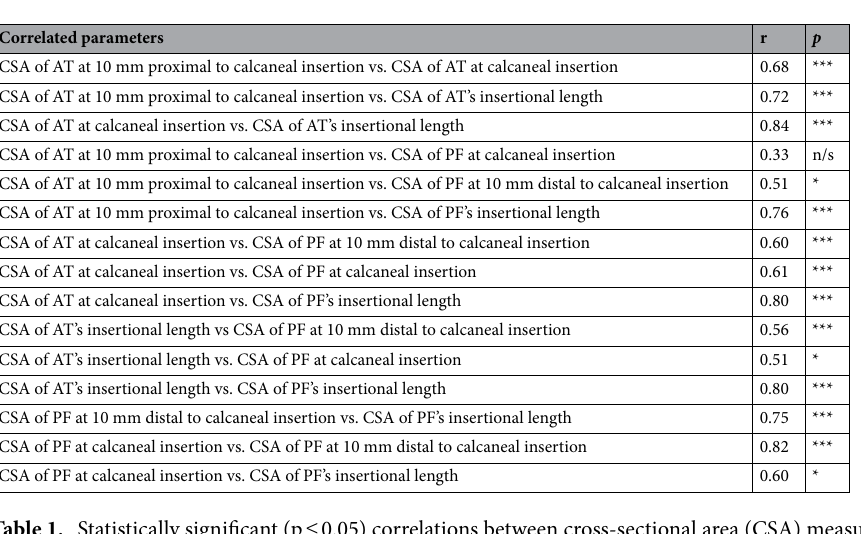
Table 1. Statistically significant (p ≤ 0.05) correlations between cross-sectional area (CSA) measurements of Achilles tendon (AT) and plantar fascia (PF); Fig. 2 provides a graphical depiction of the measurement sites. P p-value; r correlation coefficient; n/s not significant. *p ≤ 0.05, **p ≤ 0.01, ***p ≤ 0.001.